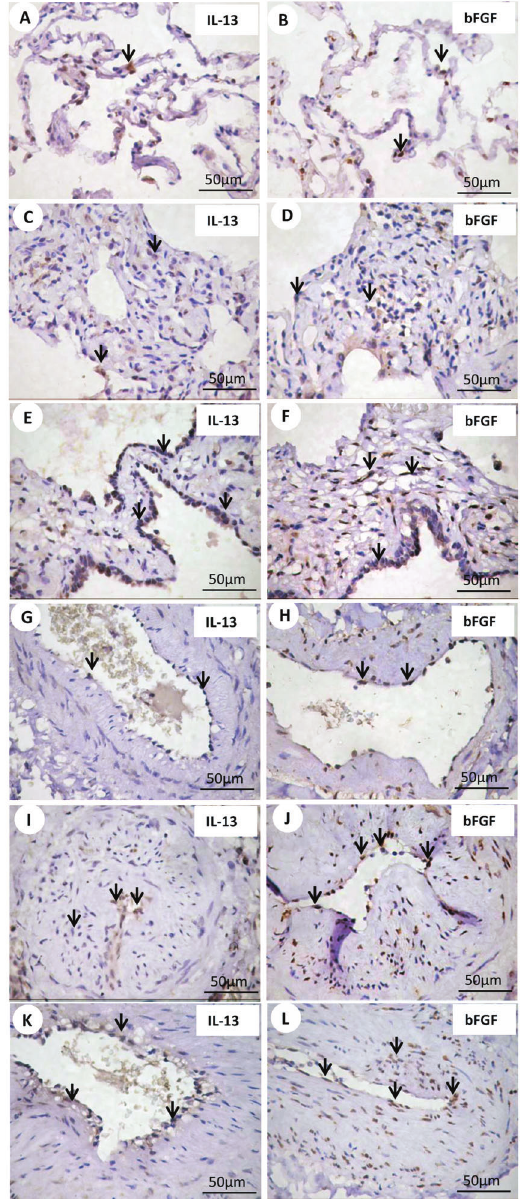
Figure 3. Immunohistochemical staining with IL-13 and bFGF. Cell expressions of IL-13 and bFGF in septal interstitium and intrapulmonary vessels from normal and systemic sclerosis (SSc) lung tissue are shown. There is an increased expression of IL-13 (arrows) ( E ) and bFGF (arrows) ( F ) in the septal interstitium from patients with fibrotic nonspecific interstitial pneumonia (NSIP) compared with IL-13 (arrows) ( A ) and bFGF (arrows) ( B ) of the control group, and IL-13 (arrows) ( C ) and bFGF (arrows) ( D ) of the cellular pattern. Similar expression is observed comparing the IL-13 and bFGF of control (arrows) ( G , H ), cellular (arrows) ( I , J ), and fibrotic (arrows) ( K , L )